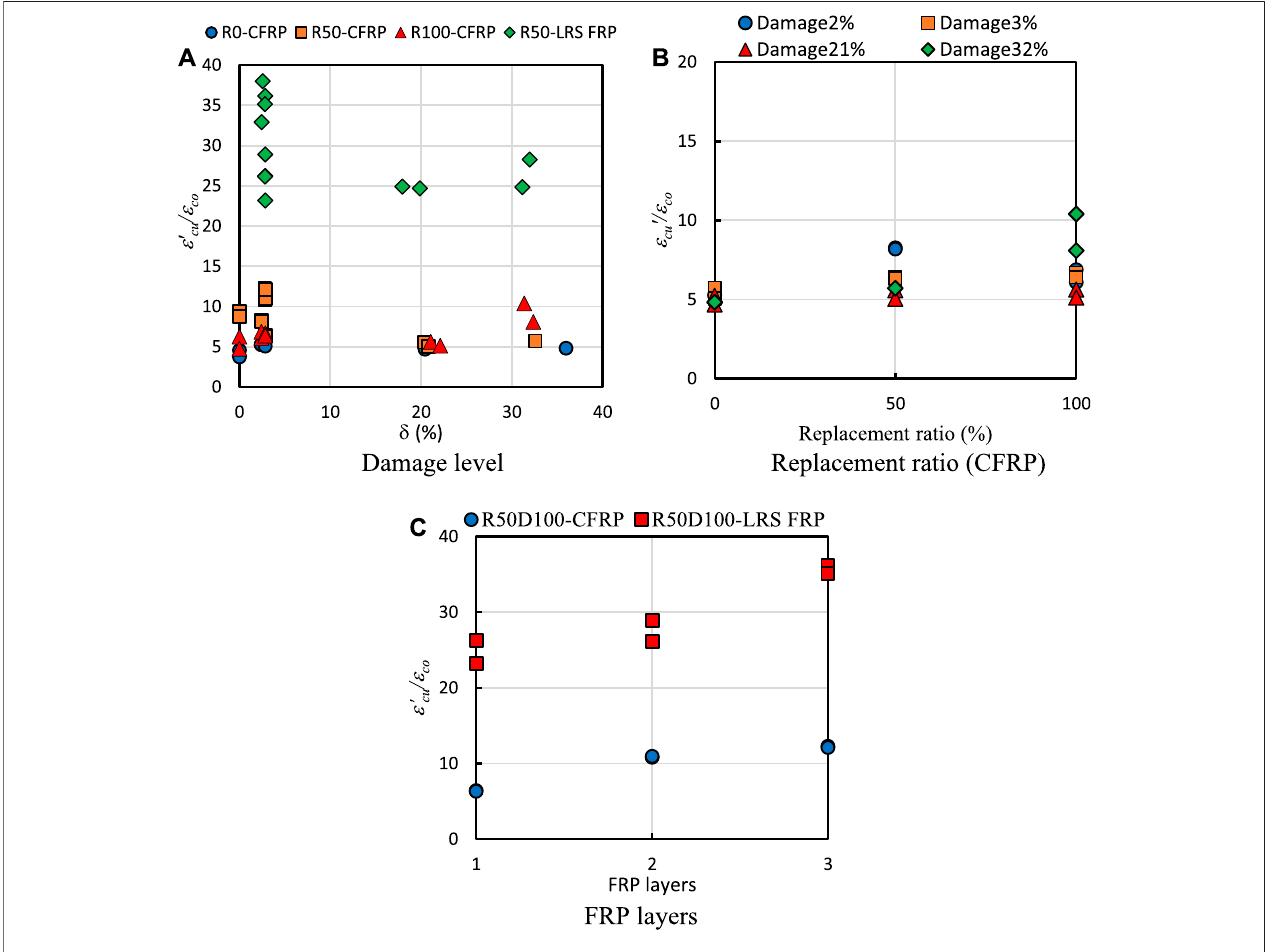
Figure 15 | Effect of damage level, replacement ratio, and FRP layers on the ultimate